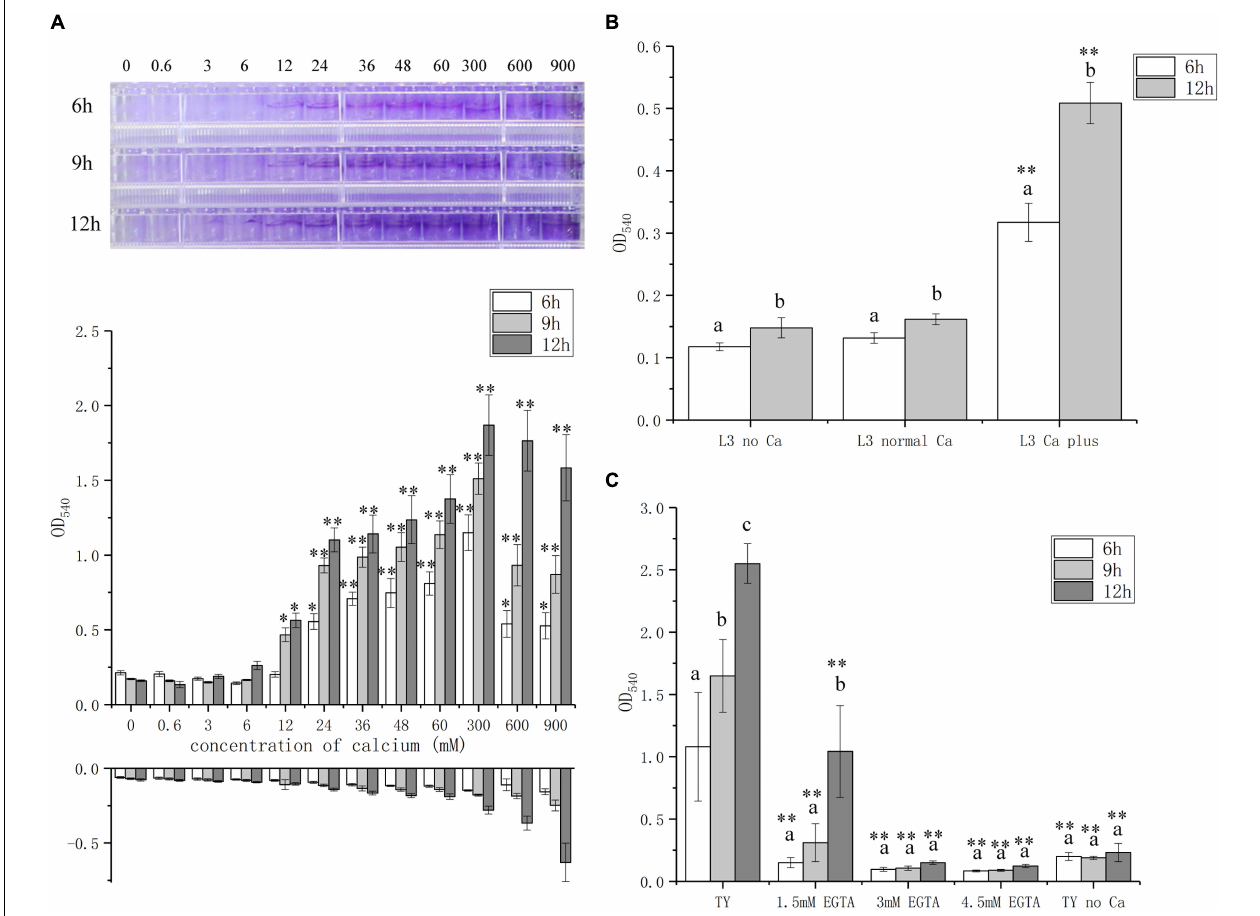
FIGURE 2 | Biofilm formation of A. caulinodans with different concentrations of calcium and calcium chelator. (A) Calcium dose (0 to 900 mM) response of A. caulinodans biofilm formation with TY medium after 6, 9, and 12 h. Below the x axis means control without adding bacteria. Images on the top show the biofilm formed on the wall of 96-well plates. (B) Biofilm of A. caulinodans with different concentrations of calcium on L3 minimal medium after 6 and 12 h. (C) Biofilm for A. caulinodans with TY adding different concentration of calcium chelator, EGTA. Values are shown as the means and standard deviations from at least three independent experiments. The same letter above the error bars indicates not statistically different with results under same treatment by a Duncan’s test. Asterisks ( ∗ ) and ( ∗∗ ) mean P < 0.05 and P < 0.01 vs. the results after culturing same time with 0 mM calcium (A) or TY medium (C) by a Student’s t